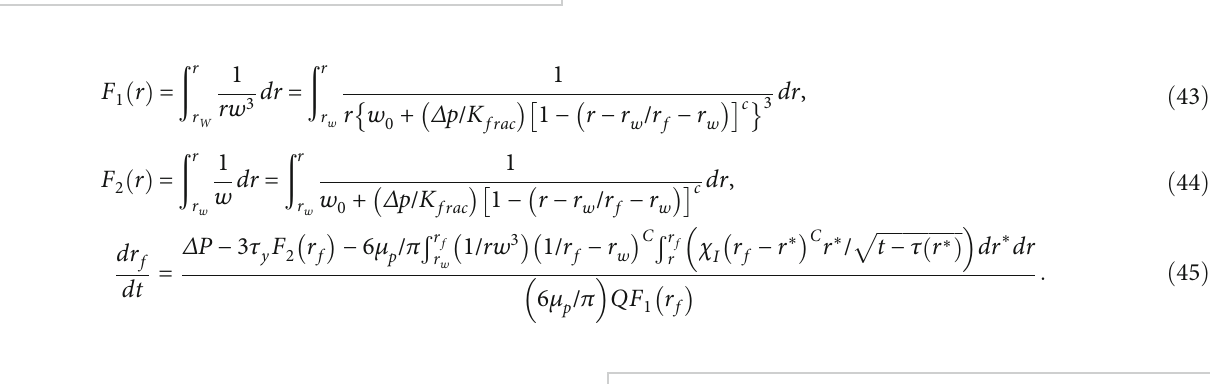
ffiffiffiffiffiffiffiffiffiffiffiffiffiffiffiffiffi p t − τ ð r ∗ Þ Þ dr ∗ dr in Eq. (46)